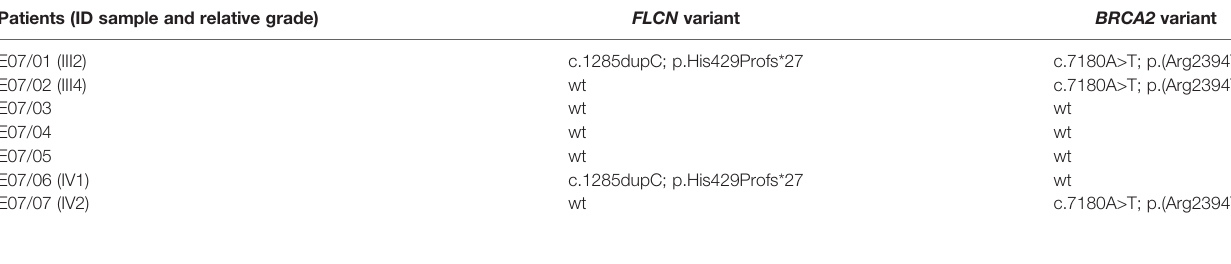
TABLE 5 | FLCN and BRCA2 variants identi fi ed in the proband and in family members. Patients (ID sample and relative grade)